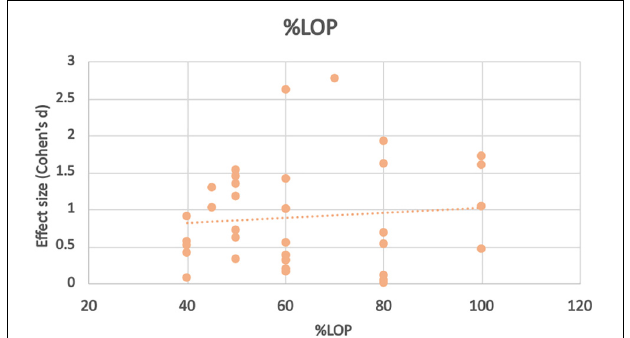
FIGURE 3 | Effect size observed at different%LOP applied during BFR exercise intervention with trendline.